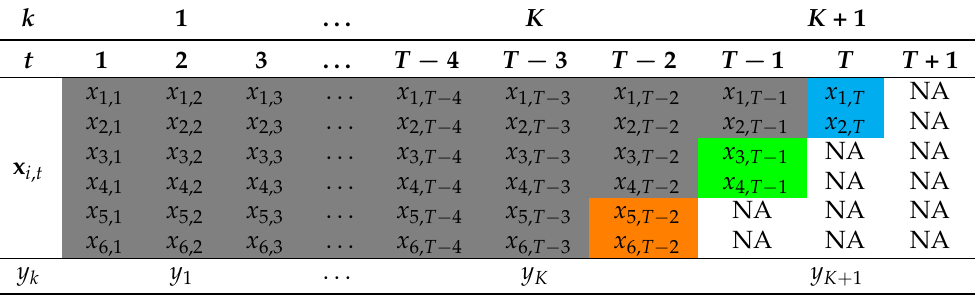
Table 1. An example of the overall releasing pattern. Gray colored cells represent available series before T . Orange, green, and blue represent the 1st, 2nd, and 3rd release within T , respectively. k 1 . . . K K + 1 t 1 2 3 . . . T − 4 T − 3 T − 2 T − 1 T T + 1 . . .